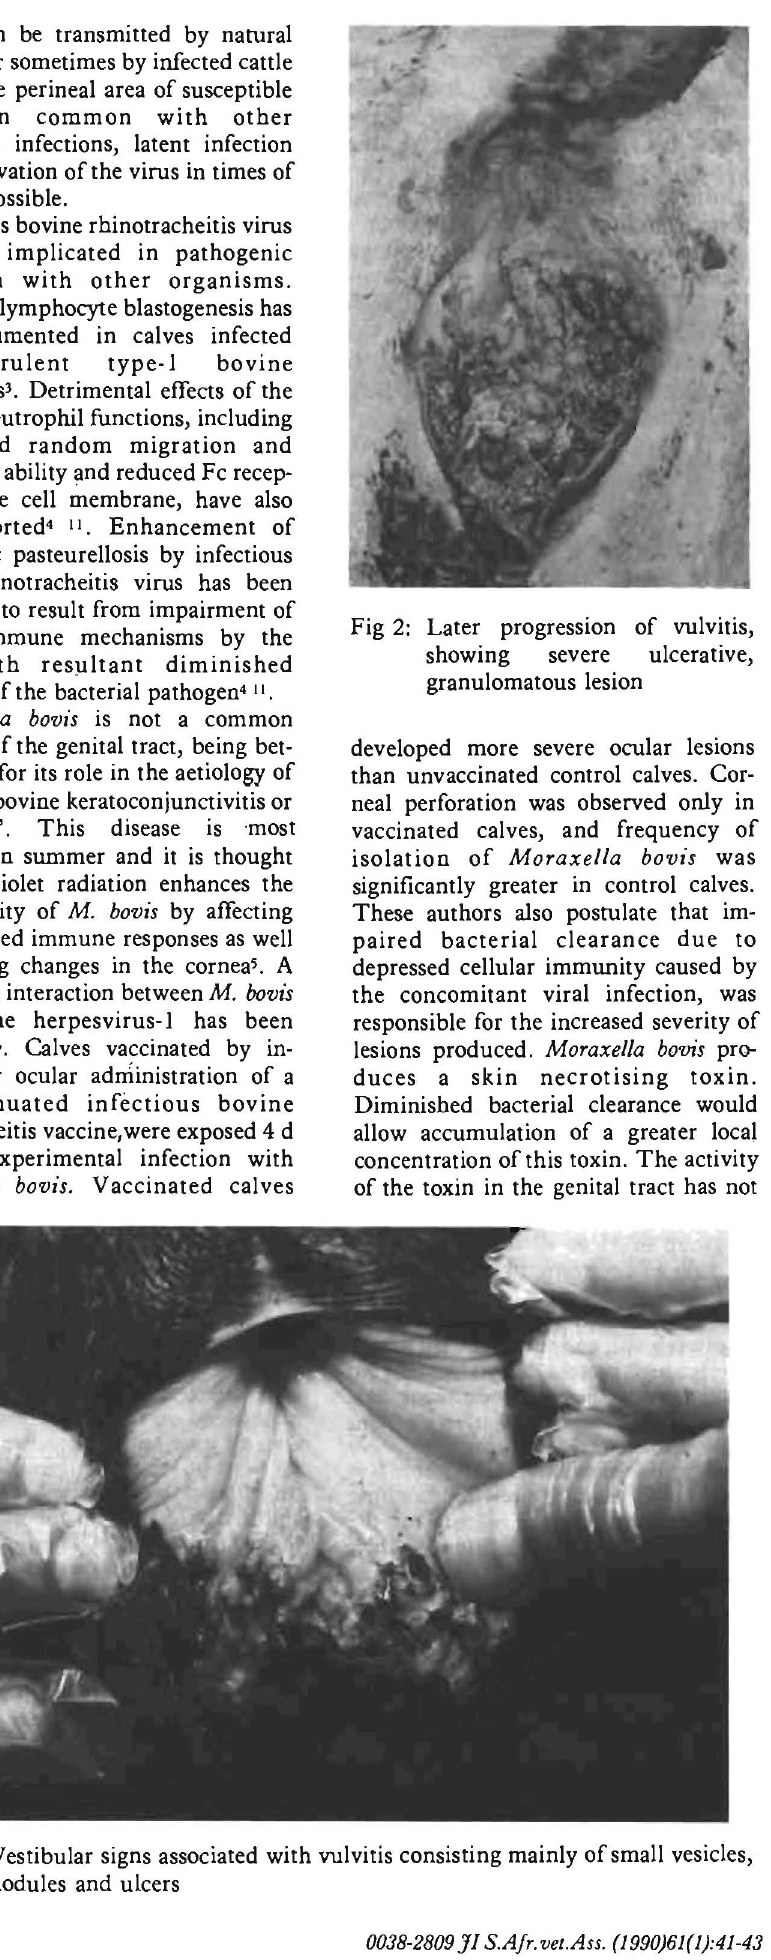
Fig 3: Vestibular signs associated with vulvitis consisting mainly of small vesicles, nodules and